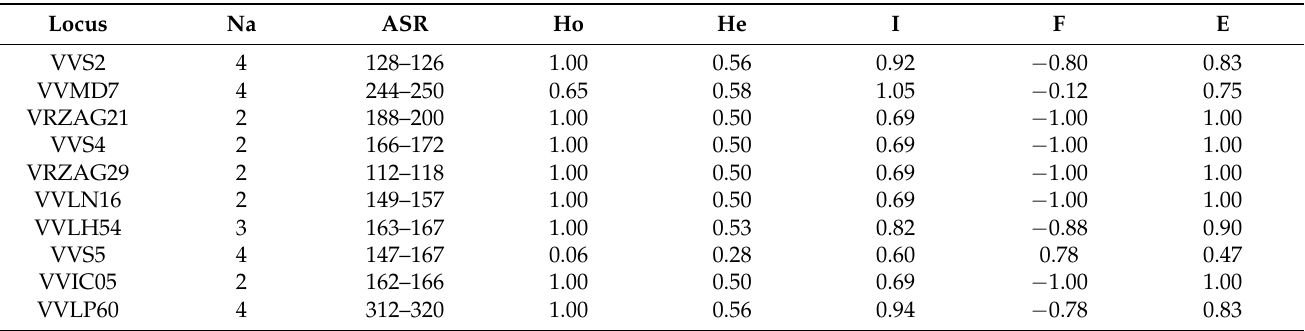
Table 4. Main genetic indexes of diversity in the analyzed population of ‘Greco’ clones. Na—number of alleles; ASR—allelic size range; Ho—observed heterozygosity: He—expected